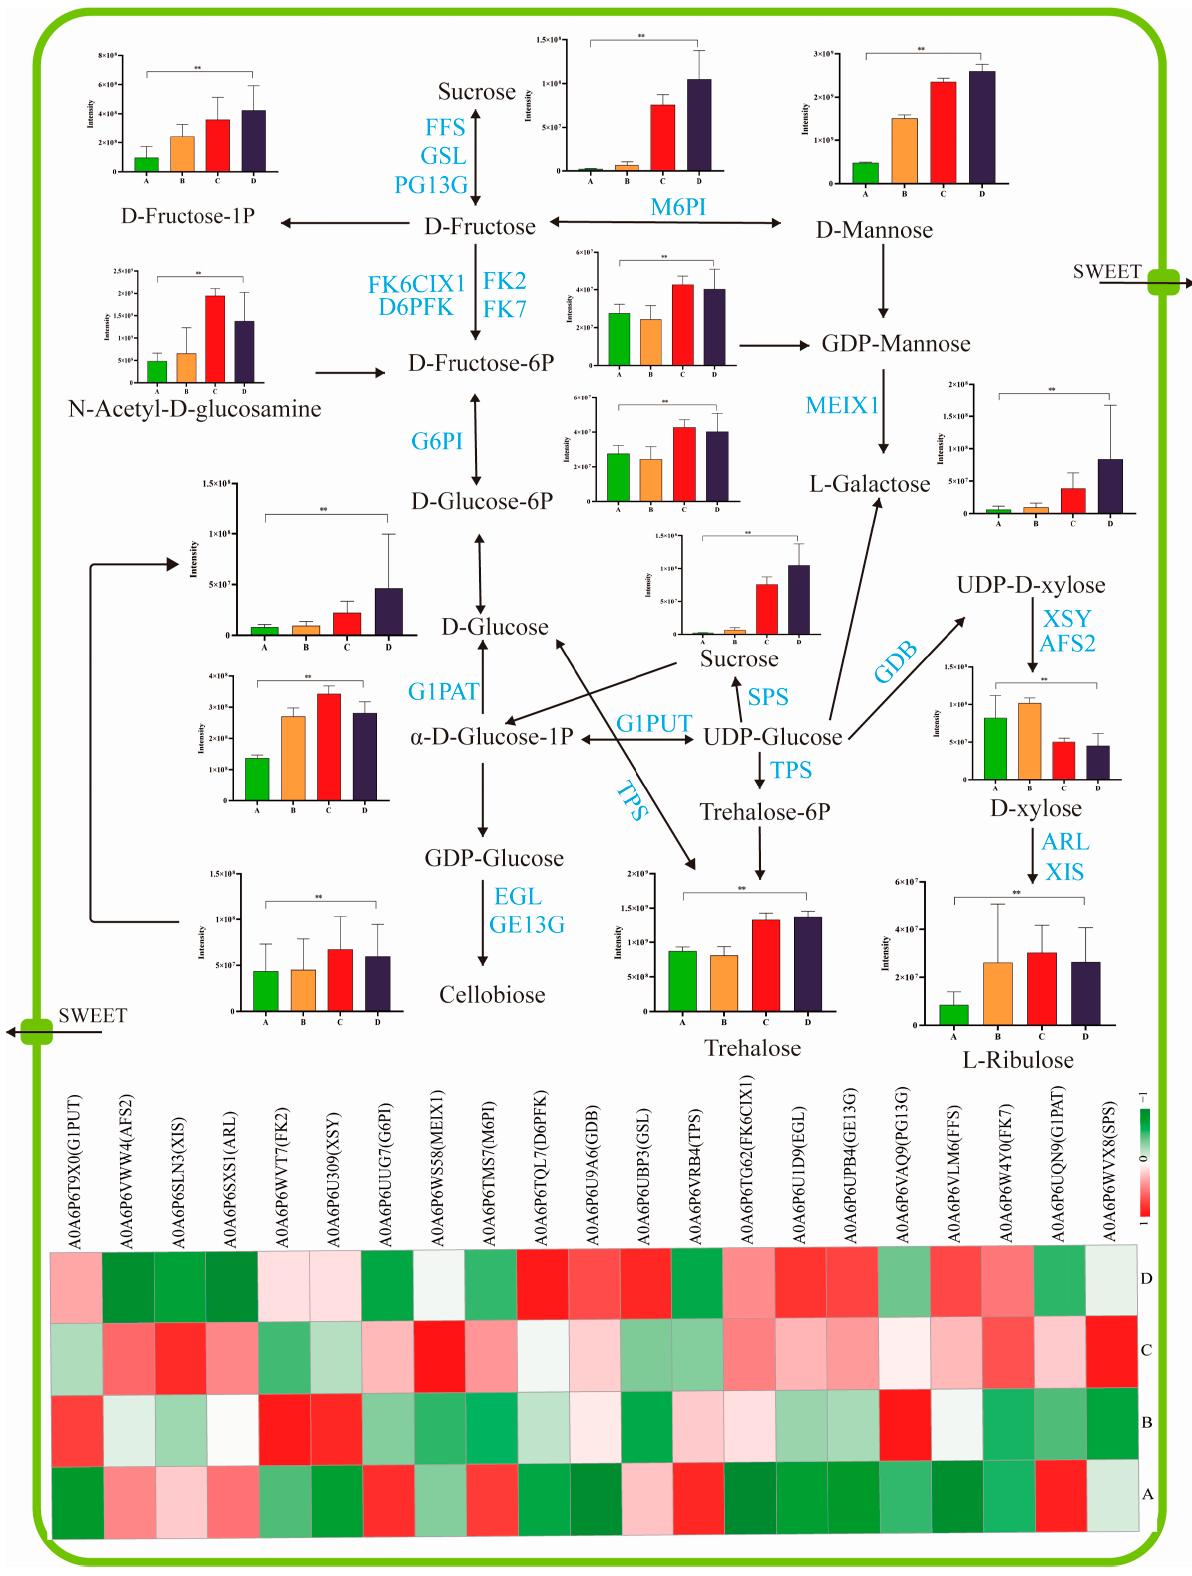
Figure 4. Pathway viewer of main sugar metabolism in coffee cherries. The ripening progression of protein expression from A to D is presented in four box strings. “**” represents the significant differences ( p < 0.01). Putative protein families were from the Coffea Arabica L. genome database.